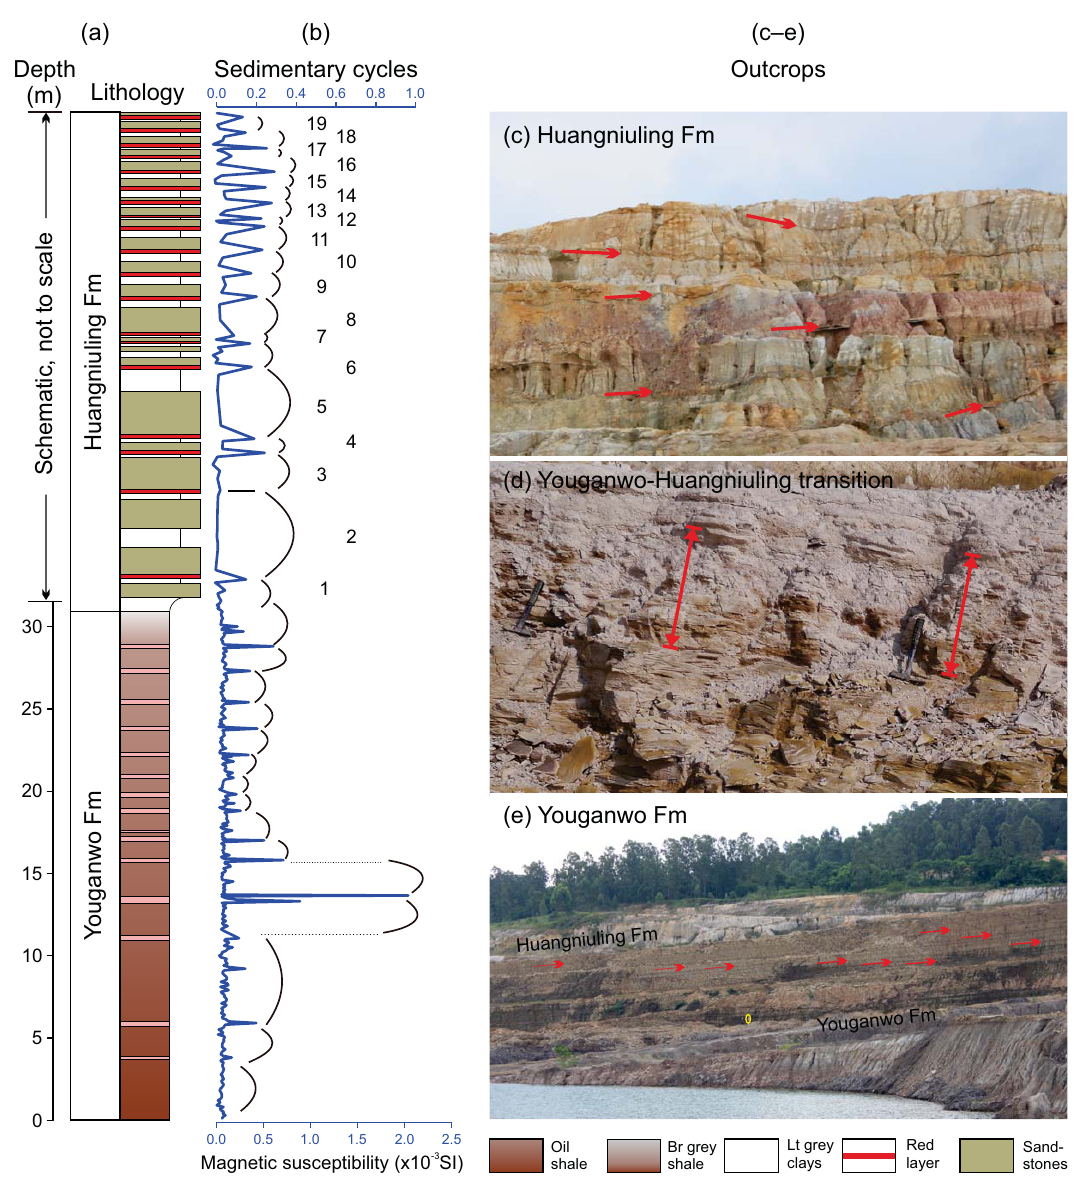
Figure 2. Stratigraphy of the investigated section exposed in the now abandoned open mine pit in the Maoming Basin. Lithostratigraphic column (a) shows that the investigated section contains the Youganwo Fm and the overlying Huangniuling Fm. The stratigraphic column of the upper part of the Huangniuling Fm schematically shows the overall rhythmic sedimentary feature that is characterized by the repeated occurrence of a sedimentary package that is composed of a thin bed (shown in red lines) of red sandstone at the base, massive grey sandstone in the middle, and a light grey mudstone bed at the top. The Youganwo Fm also exhibits sedimentary rhythms that are characterized by repeated occurrence of the beds with distinct reddish color (shown in pinkish lines) visible from a distance. Sedimentary cycles (b) are re- flected by magnetic susceptibility data. The distinct reddish beds in the Youganwo Fm and the thin red sandstone layers in the Huangniuling Fm generally correspond to the magnetic susceptibility peaks. The distinct thin red sandstone layer of a sedimentary package in the Huang- niuling Fm is numbered and a total of 19 sedimentary packages are identified. Note the different scales of the magnetic susceptibility of the Youganwo Fm (the lower part) and the Huangniuling Fm (the upper part). Field photographs (c–e) show the major sedimentary features of the two formations and the contact between them. In (c) , the red arrows indicate the red, thin marker bed of sandstone in the Huangniuling Fm. In (d) , the arrow marks the contact between the two formations, displaying a continuous, gradual transition from brown grey mudstones in the uppermost section of the Youganwo Fm to pale grey mudstones at the base of the Huangniuling Fm. In (e) , the yellow ellipse at the lower–middle part of the picture marks a person ( ∼ 1.6m) for scale; red arrows point to several distinctive reddish layers that form the sedimentary rhythms in the Youganwo Fm; “br grey”: brown grey; “lt grey”: light grey.